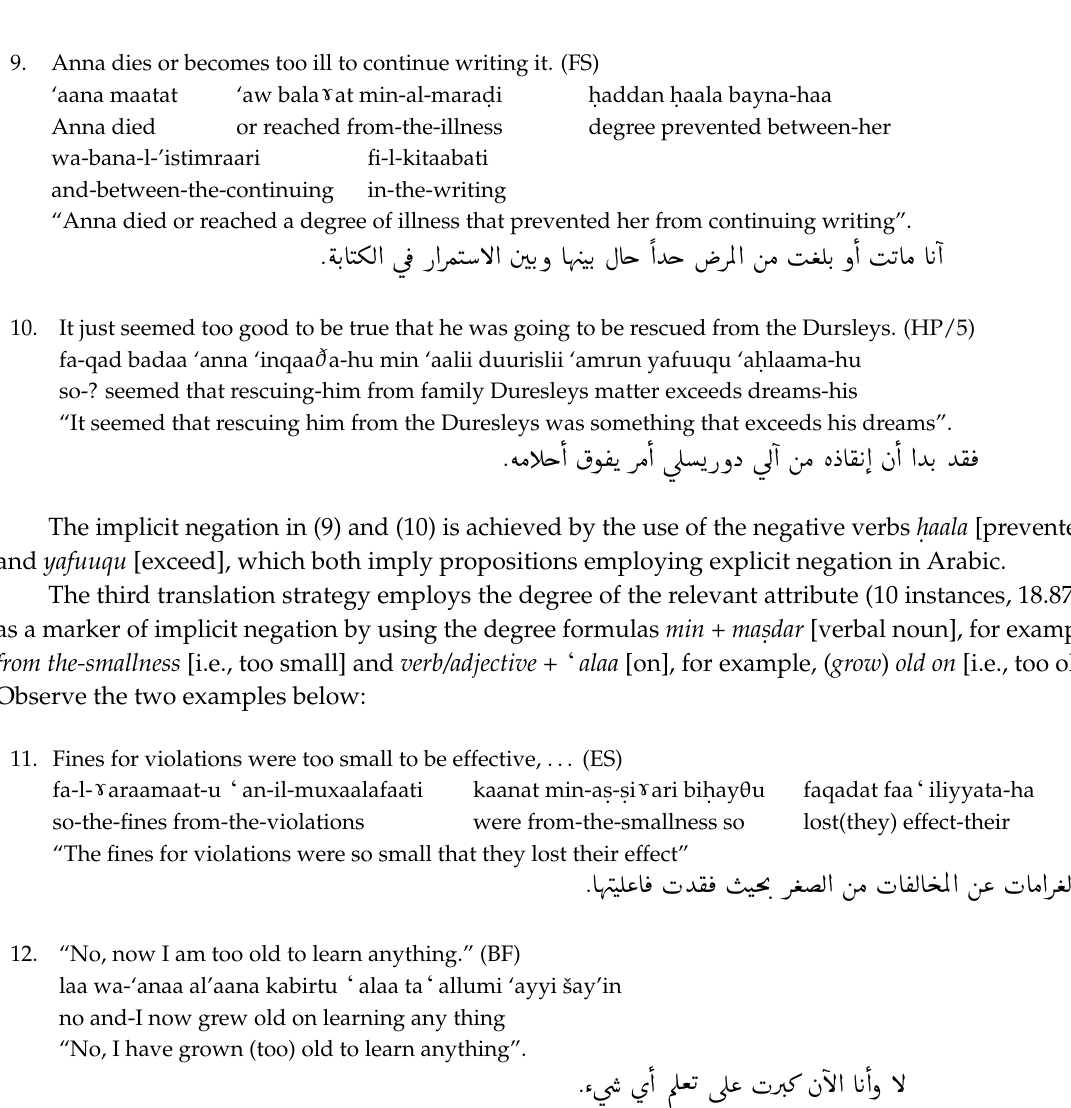
Table 4. Frequency and percentage of translation strategies in rendering -ly negation.